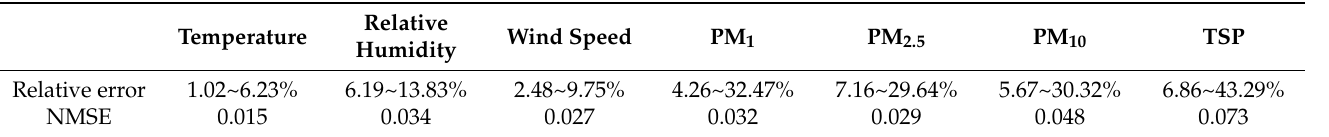
Table 4. The relative error and normalized mean squared error (NMSE) value of temperature, relative humidity, wind speed, and PM concentration (inside).